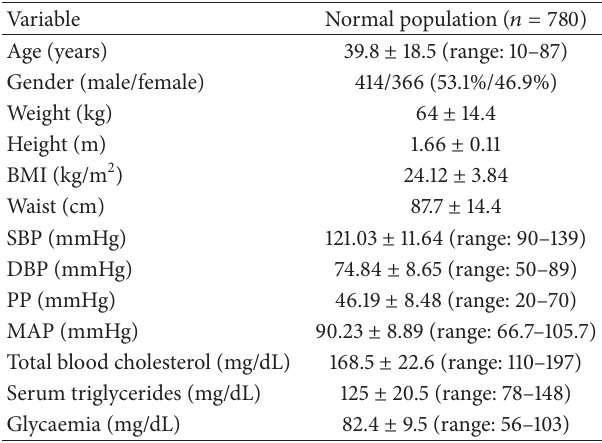
Table 1: Description of clinical and haemodynamic variables of the examined population.